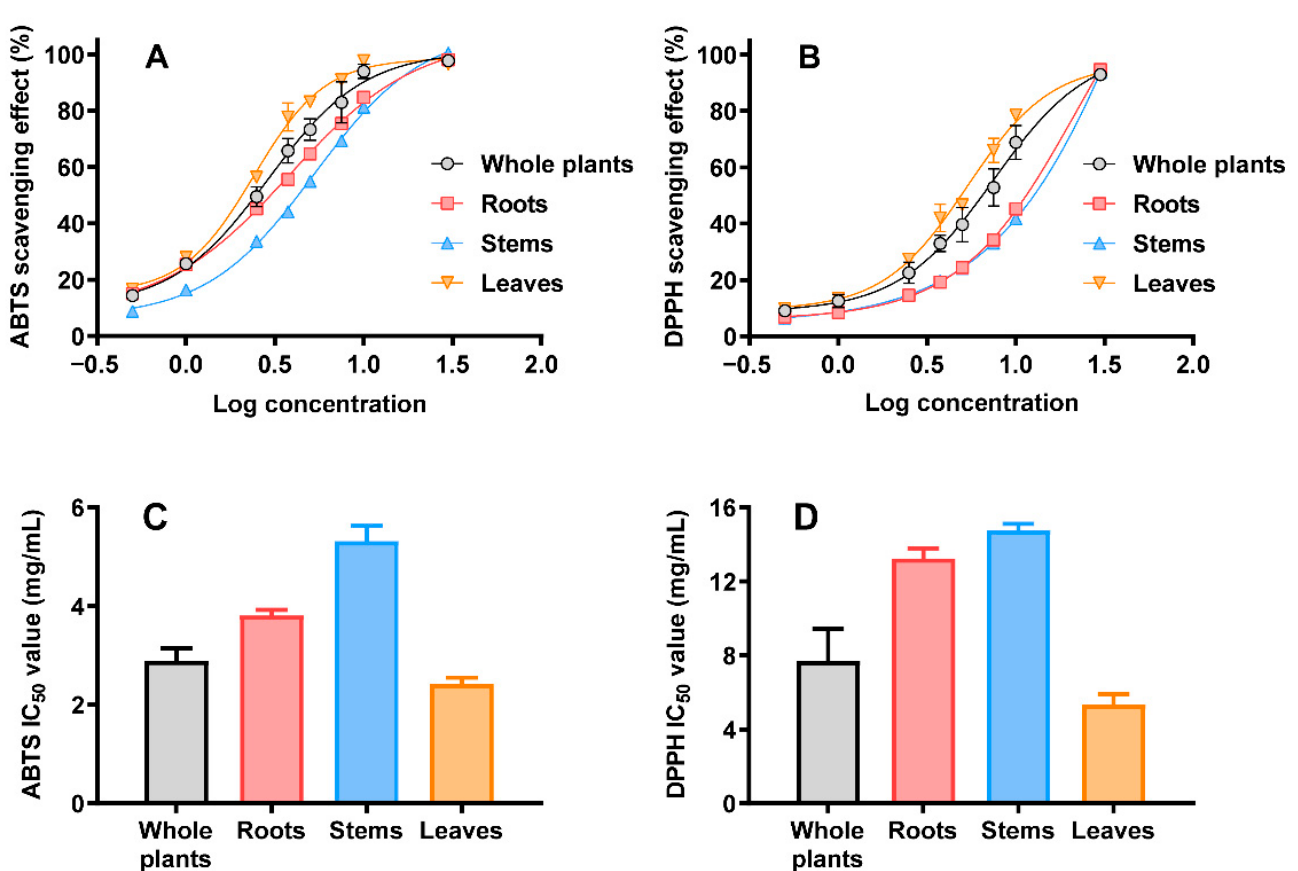
Figure 2. The radical scavenging ability of whole plants, roots, stems, and leaves from S. ternatum . ABTS ( A ) and DPPH ( B ) scavenging curves. The calculated IC 50 values for ABTS ( C ) and DPPH ( D ). The data are shown as means ± SD ( n = 3).